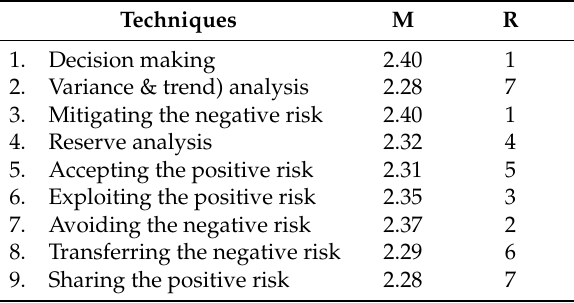
Table 5. Ranking of Risk Treatments